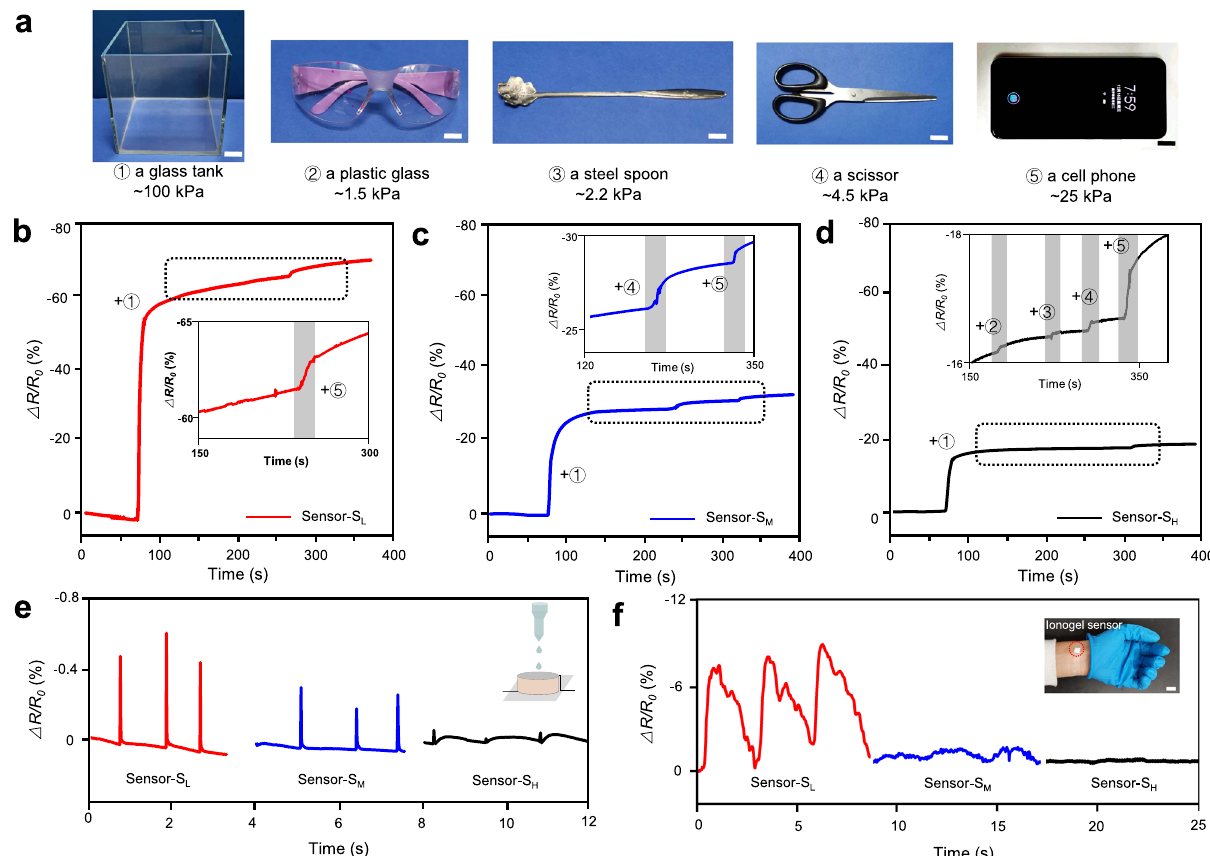
Fig. 4 Pressure resolution of the ionogel sensors with different stiffness at high pressures. a Pressure objects: a glass tank of 100 kPa, a plastic glass of 1.5 kPa, a steel spoon of 2.2 kPa, a scissor of 4.5 kPa, and a cell phone of 25 kPa. Pressure responses of b sensor-S L , c sensor-S M and d sensor-S H to different pressure objects under a base pressure of 100 kPa. The three sensors could record some or all of the loaded objects. Detection of tiny pressure changes of e falling droplet and f human pulse by sensor-S L , sensor-S M , and sensor-S H . Scale bar, 1